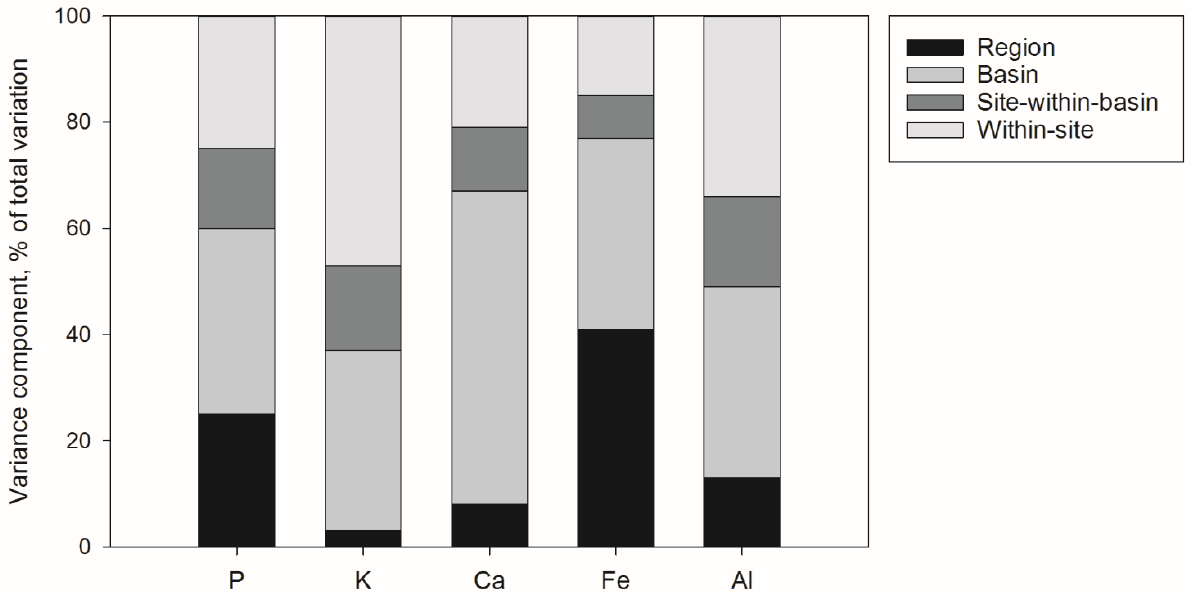
Figure 5. Relative contributions of the four hierarchical levels in a sampling design, namely: region, peatland basin (peatland complex), site within peatland basin, and within-site variation, to the total variation observed in the element concentrations of 878 peat samples collected from 289 sites in 79 peatland basins. From Laiho et al.